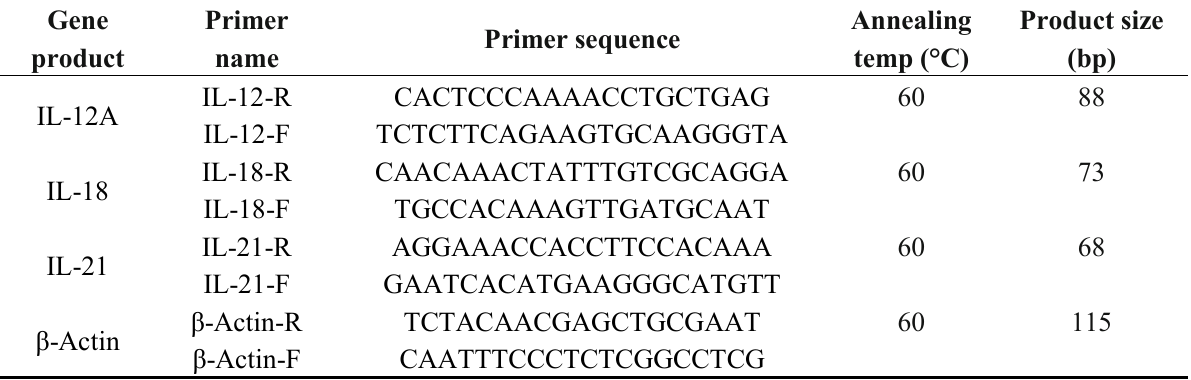
Table 1. Detailed Primers and Conditions Used for Real-Time PCR